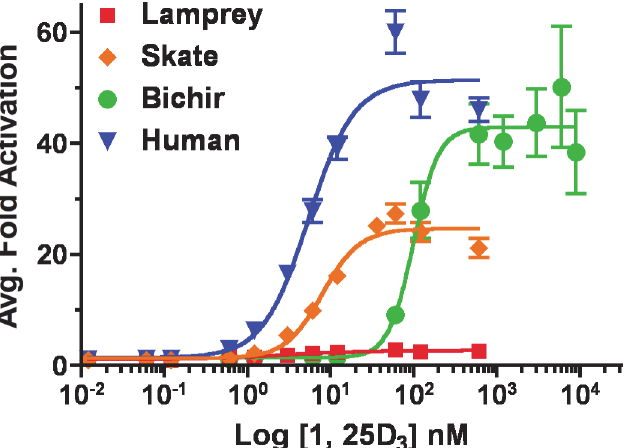
Fig 3. Transactivation of lamprey, skate, bichir, and human VDR in response to 1, 25D 3 . Concentration- response profiles are shown for lamprey VDR (red), skate VDR (orange), bichir VDR (green), and human VDR (blue). HepG2 cells were transiently transfected with full-length pSG5-VDR, the XREM-Luc reporter, and the pRL-CMV internal luciferase control as described previously in Materials and Methods. Cells were treated with 0 – 1200 nM 1, 25D 3 in media for 24 hours. VDR response was measured via dual-luciferase assays. Data are represented as the mean fold activation normalized to the ethanol control ± SEM (n = 4). The half-maximal effective concentration (EC 50 ), 95% confidence interval (95% CI), and maximum efficacy (E MAX ) values for each VDR was determined using nonlinear regression analysis using a sigmoidal dose- response calculation with variable slope in Prism 4.